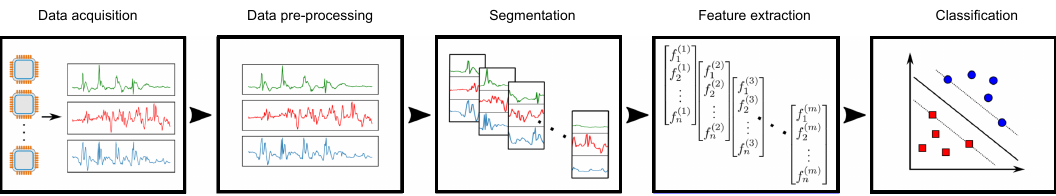
Figure 2. Activity recognition chain defined in [16] which includes the following (from left to right ): data acquisition, signal preprocessing, segmentation, feature extraction, classification, and evaluation stages. From